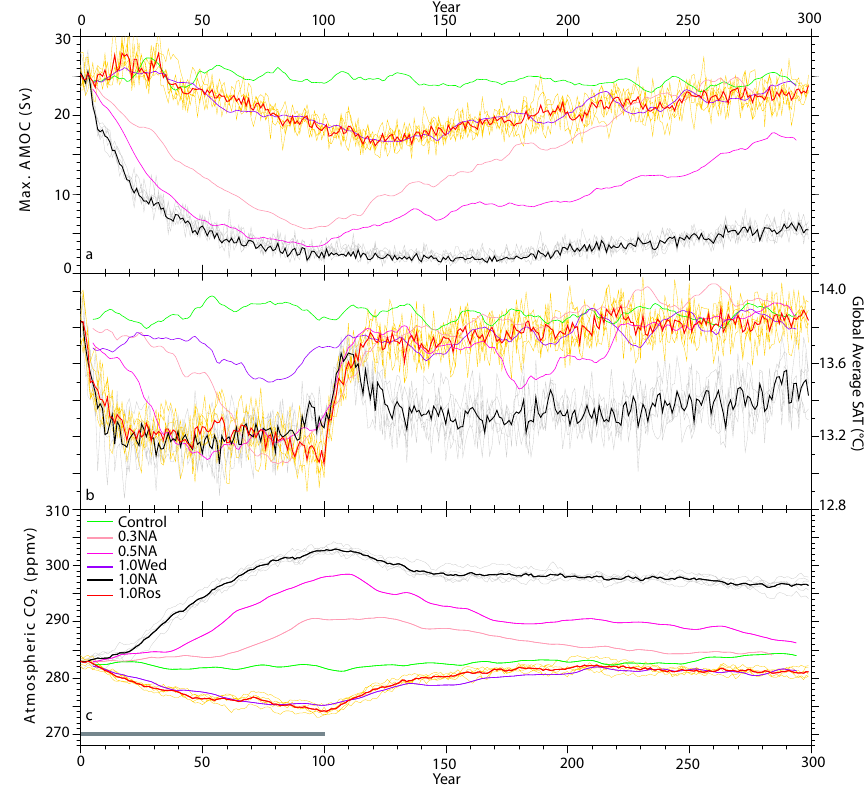
Fig. 1. Time series of: (a) Maximum North Atlantic MOC strength (Sv), (b) Global Annual Mean SAT ( ◦ C) and (c) surface atmospheric CO 2 concentration (ppmv). The green curve represents the Control; pink and magenta represent the smaller perturbations from the NA of 0.3 and 0.5Sv, respectively, and violet represent the 1.0Wed perturbation. The other two perturbations of 1.0NA (black) and 1.0Ros (red) are given as the averages of five ensemble members and the grey and orange curves in the background are the five individual runs in each ensemble, intended to show the spread of the anomalies. The values are 10-year box averages. The grey bar at the bottom marks the duration of the freshwater